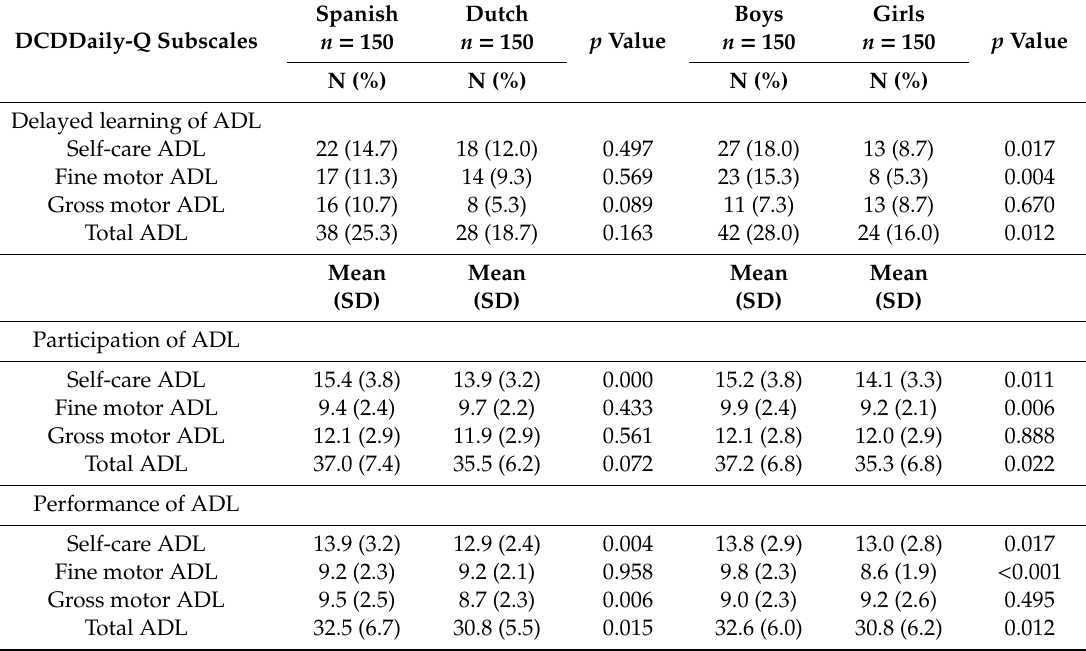
Table 1. Learning, participation, and performance of ADL according to country and sex ( n = 300). DCDDaily-Q Subscales